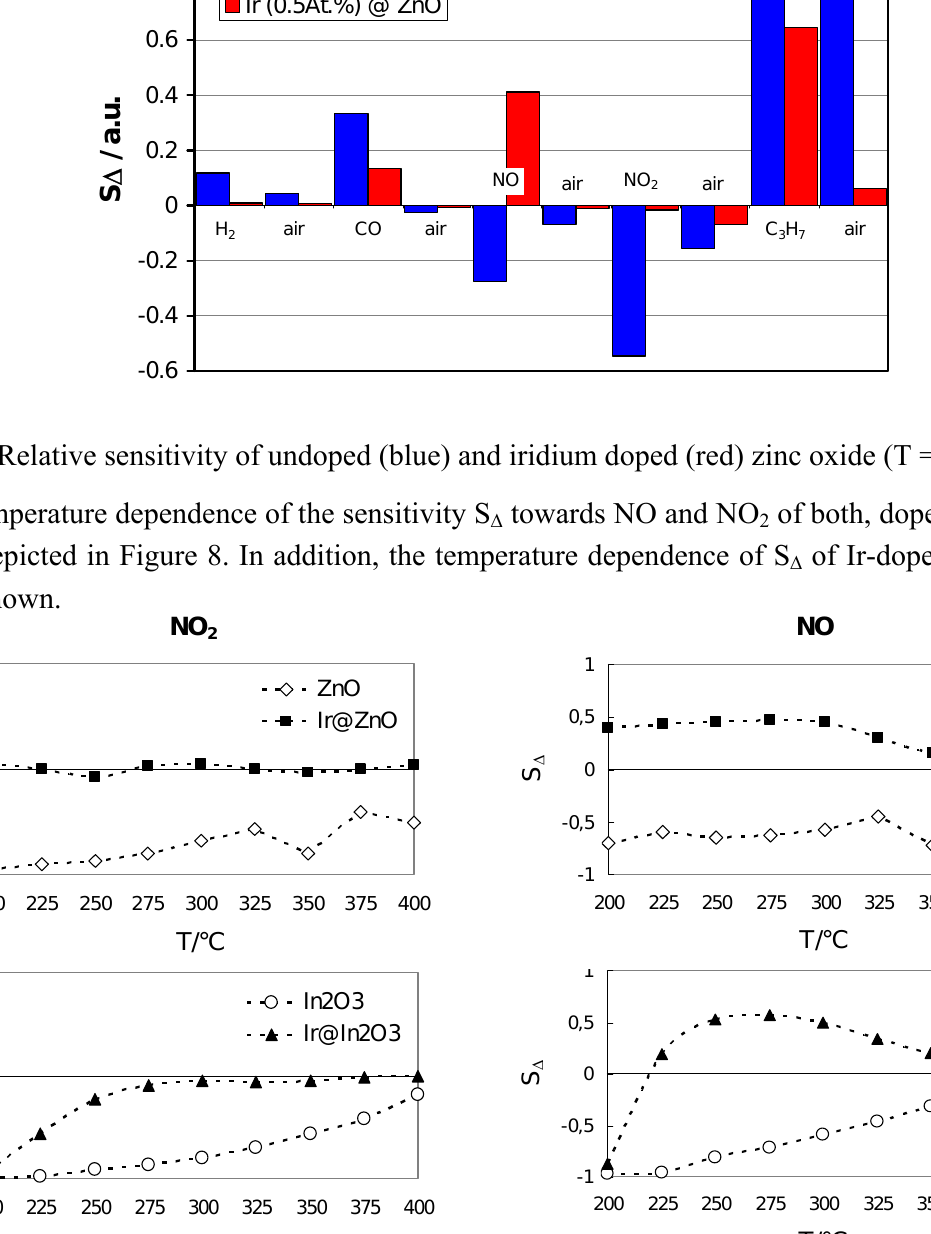
for Ir-doped and ∆